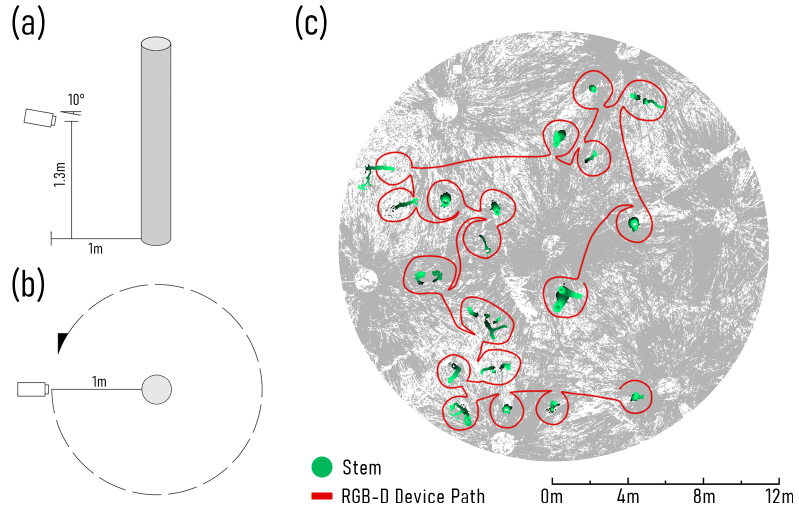
Figure 2. ( a ) Depicts how colour and depth (RGB-D) devices were held relative to each stem during capture, ( b ) shows how each stem was circumnavigated using both the individual stem and continuous capture approaches, and ( c ) provides an example of the path used to move the RGB-D devices through a plot at S2, native woodland, using the continuous capture